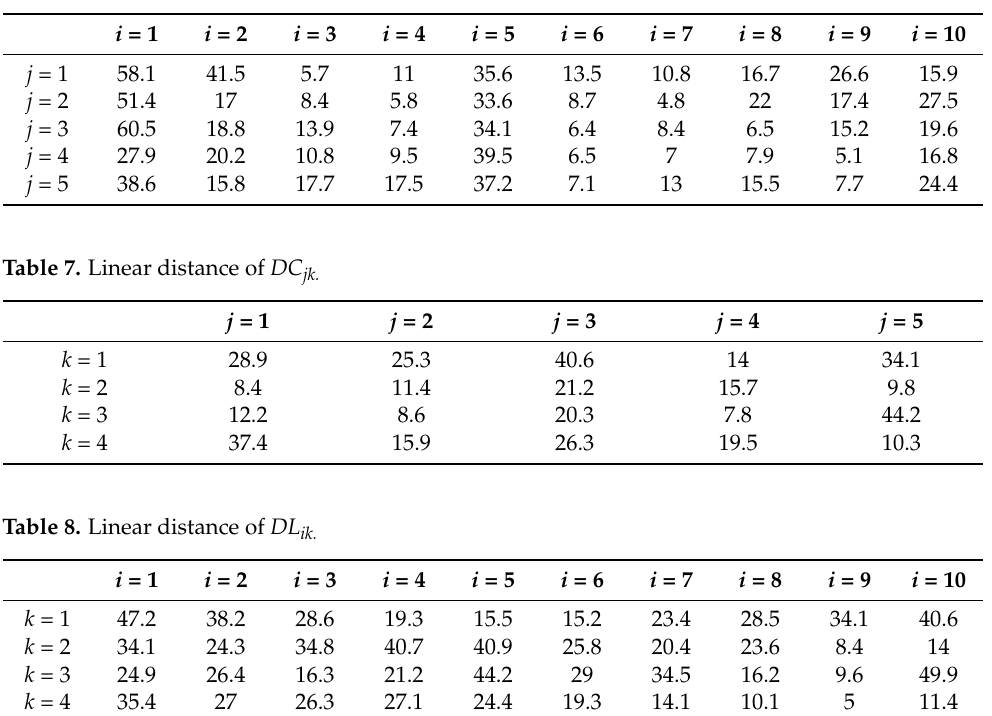
Table 6. Linear distance of DT ij.